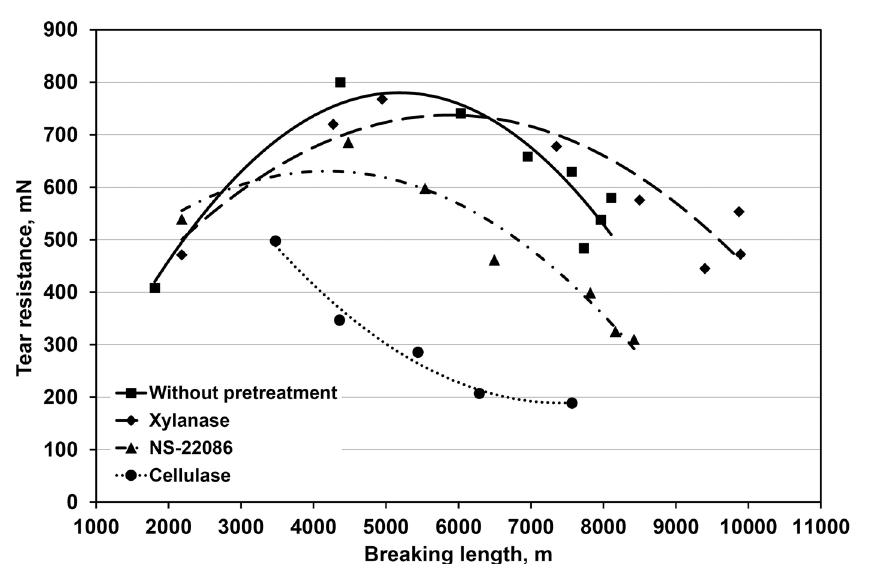
Fig 4. The dependence of tear resistance: breaking length ratio on enzymatic pulp